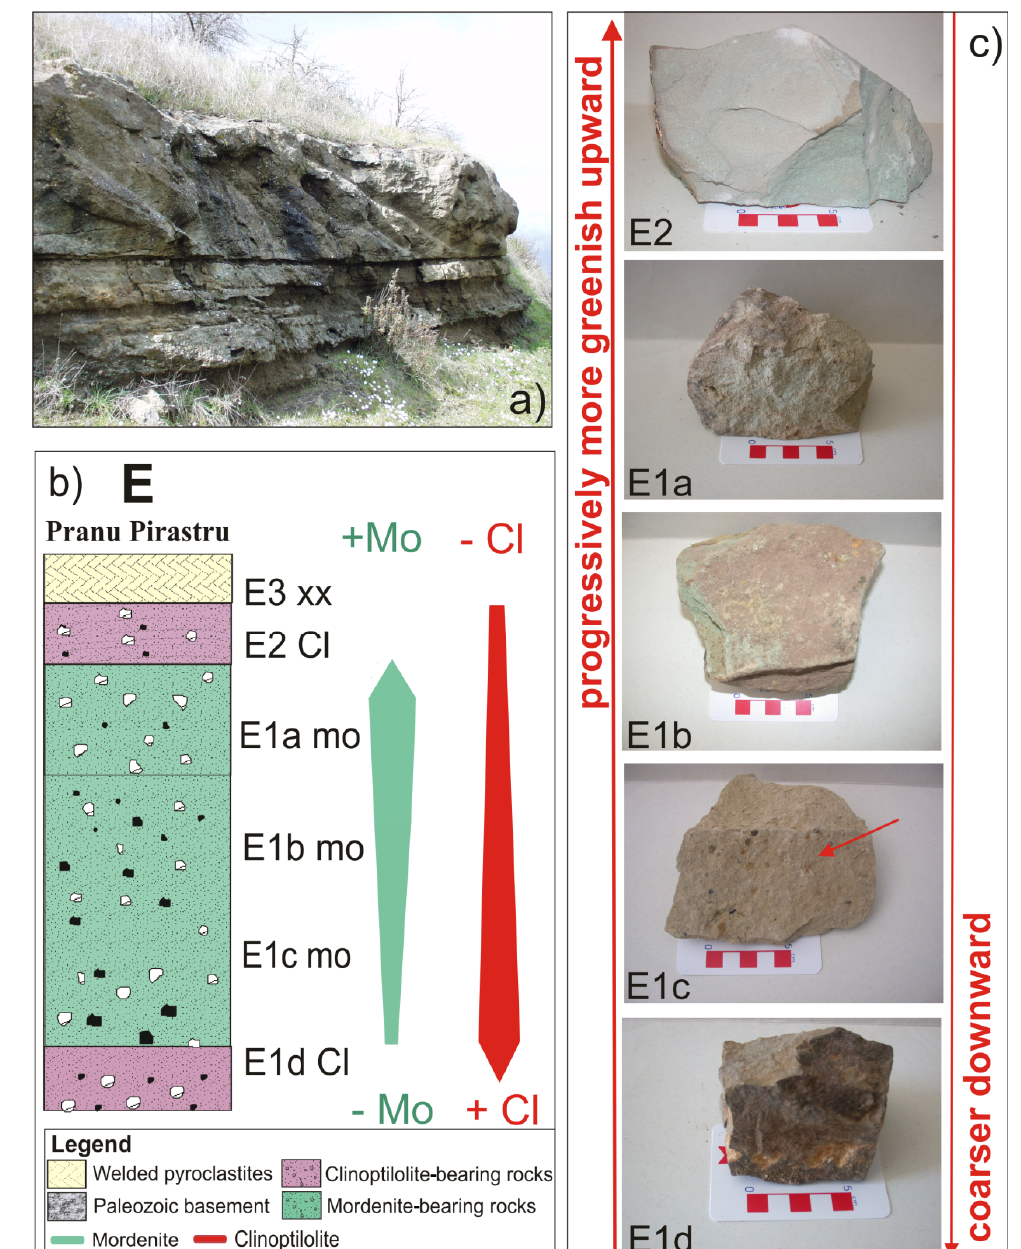
Figure 4. The Asuni unit at Pranu Pirastru (Pranu in Figure 1). ( a ) Representative laminated outcrop deposit; ( b ) reconstructed “E” lithostratigraphic sequence and relative zeolites vertical distribution; ( c ) photos of selected samples arranged base-upward to show the vertical textural change. The scale bar is 5 cm. See Supplementary Materials Figure S1 for XRPD patterns of the zeolite-bearing samples.